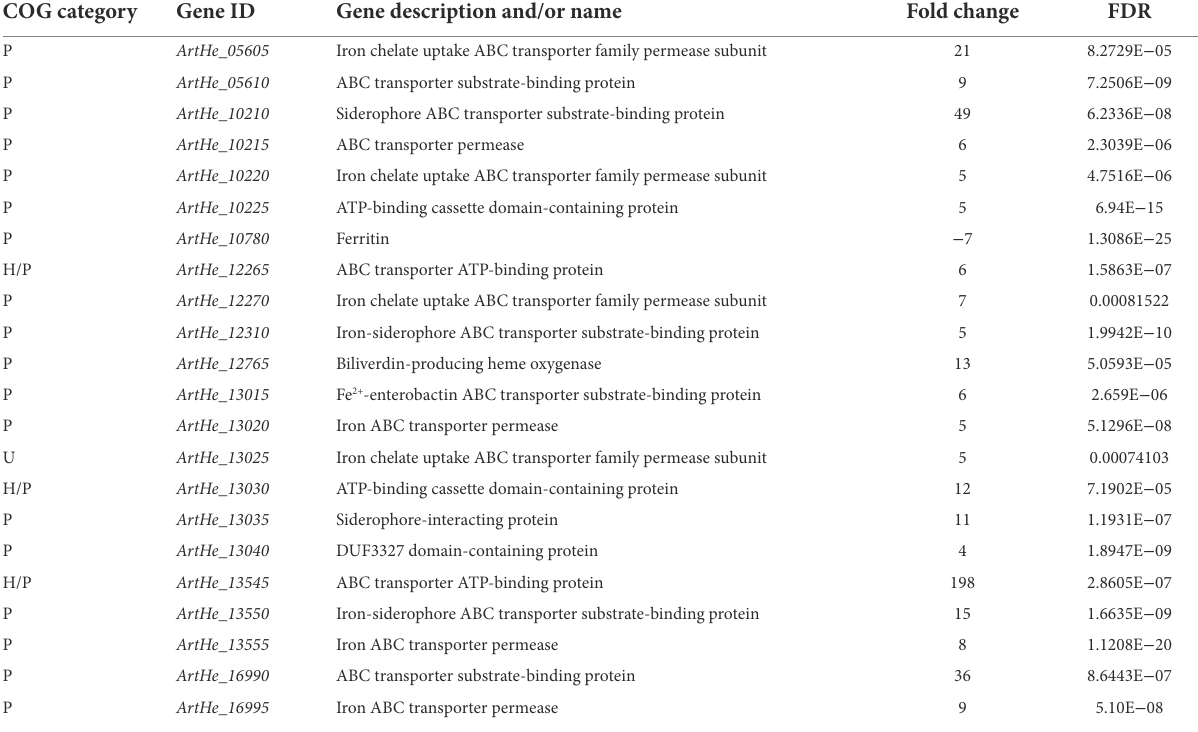
TABLE 4 DEGs related to iron homeostasis in PEG35 vs.